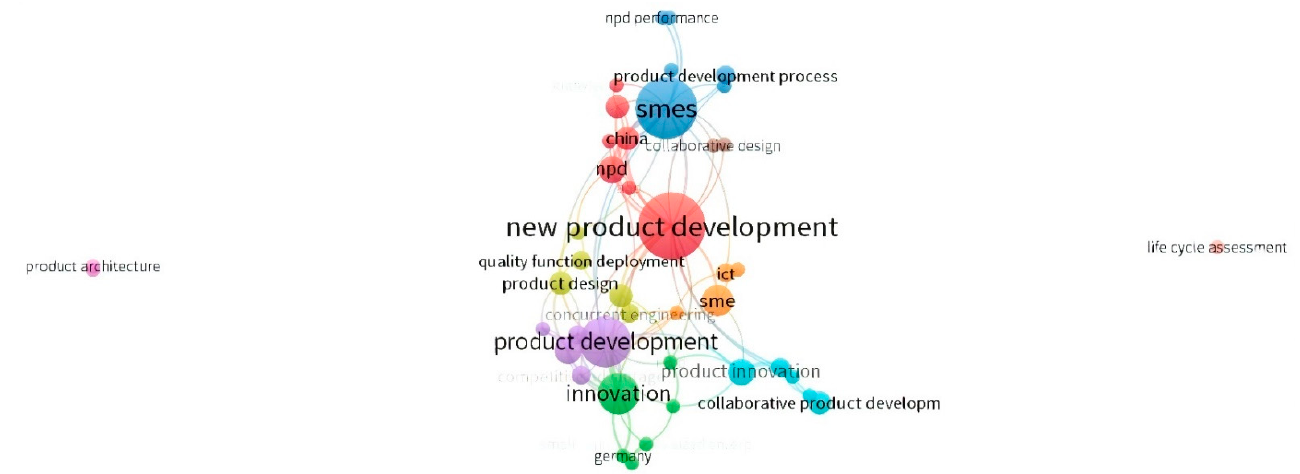
Figure 5. Keyword’s analysis.